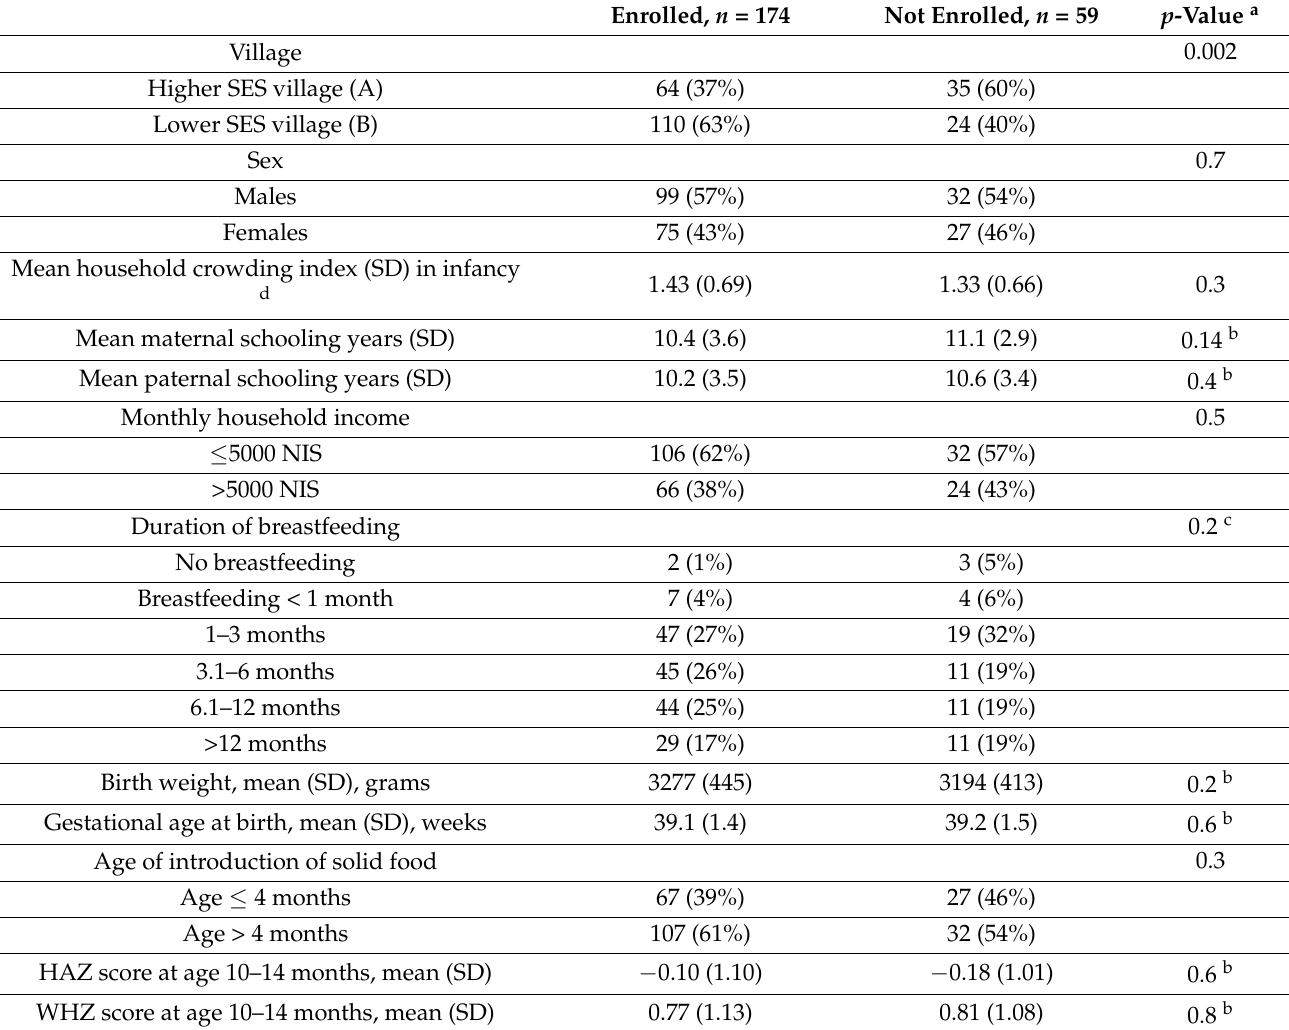
Table 1. Baseline characteristics compared between children who were enrolled in the follow-up study and children who were not (refusals, not found,